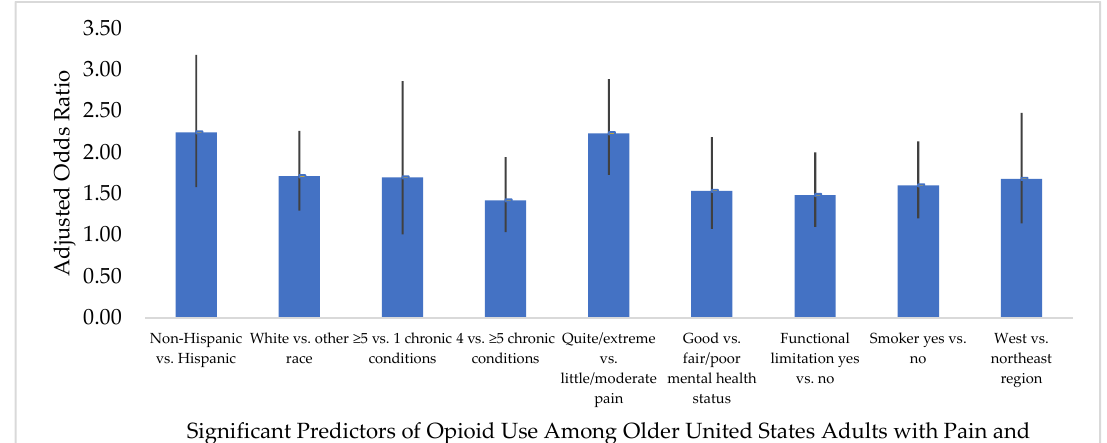
Figure 2. Predictive characteristics of opioid medication use among older United States adults (age ≥50 years) with pain in the past four weeks and a diagnosis of hypercholesterolemia. Pain–hypercholesterolemia group: unweighted sample n = 2796 (opioid use n = 795; non-users n = 2001) reflects weighted sample n = 31,014,839 (opioid users n = 8,835,304; non-users n = 22,179,535) of United States adults alive during the calendar year 2017, age ≥ 50 years, with self-reported pain in the past four weeks, and a diagnosis of hypercholesterolemia. “No opioid use” served as the reference group for the dependent variable in the binomial logistic regression. Only characteristics that were significant predictors of opioid use are included in the figure.